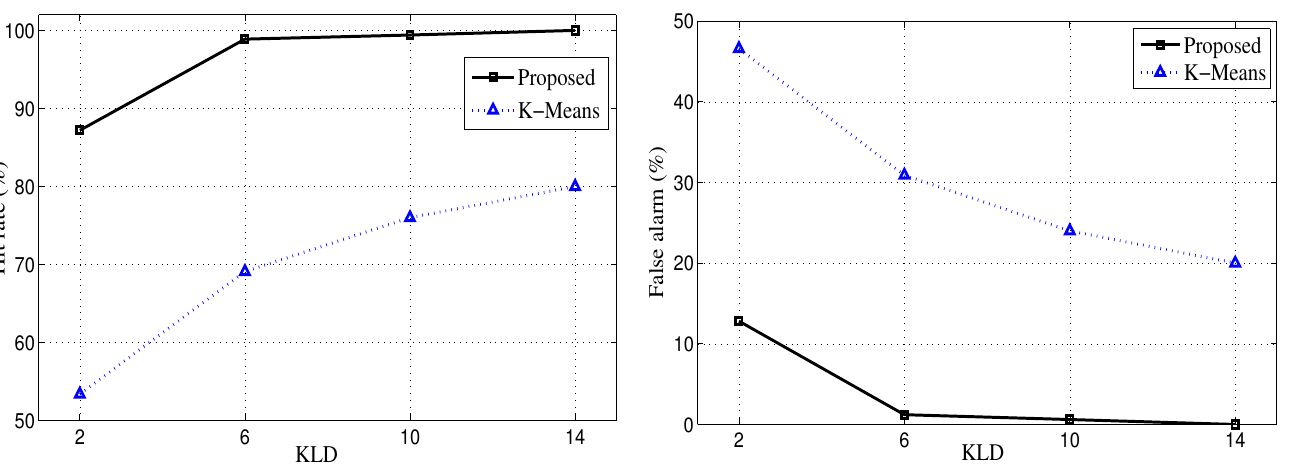
Figure 10. Clustering accuracy ( left , hit rate; right , false alarm) with KLD variations for the proposed algorithm and the K-Means